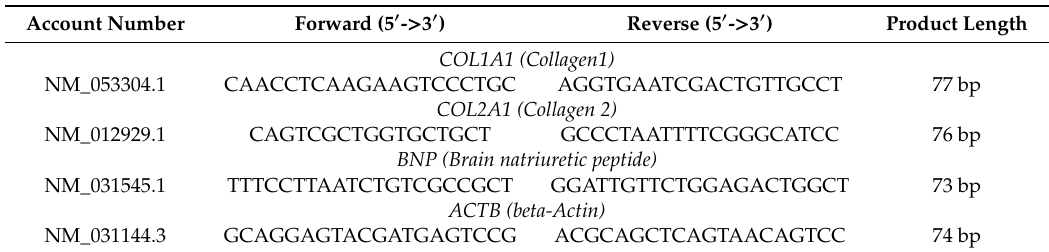
Table 1. Genes used for quantification and primer information.